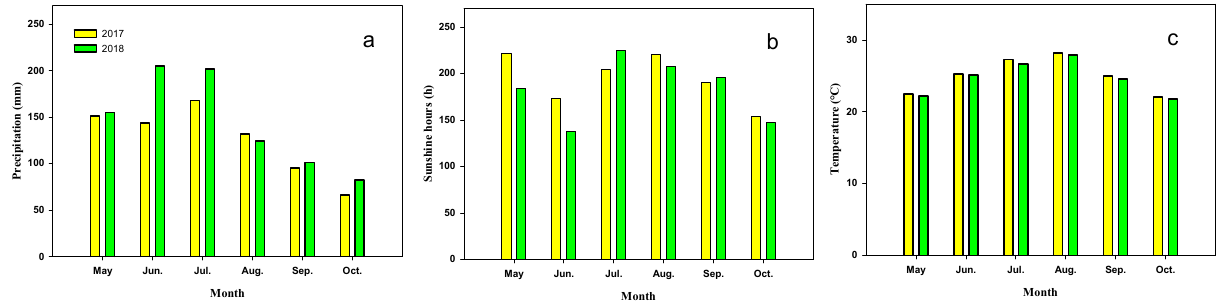
Figure 2. Precipitation ( a ), sunshine hours ( b ), and temperature ( c ) during the growing season of rice in 2017 and 2018 at the field site of Yangzhou, China.